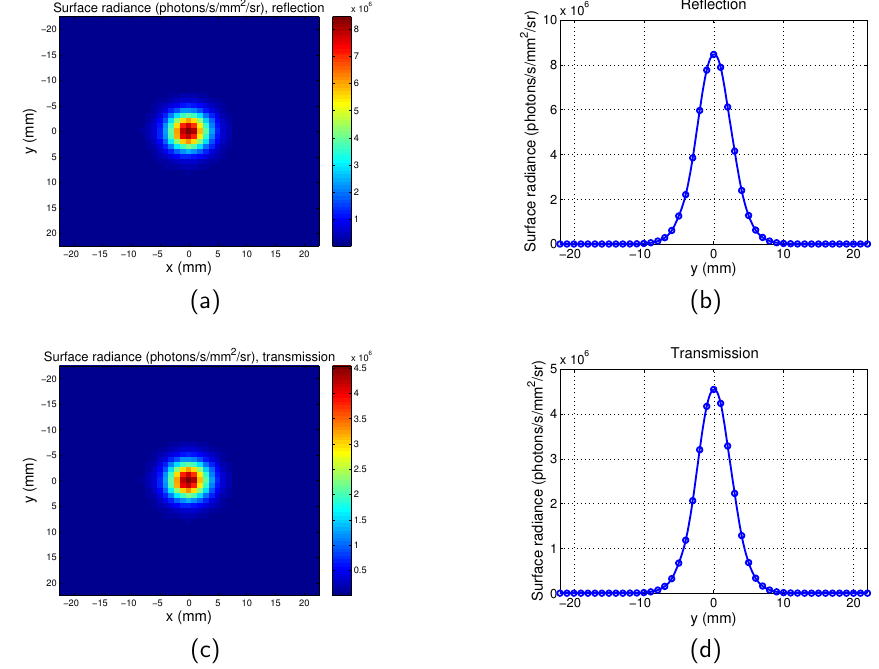
Figure A2. Point spread function for scanning imaging system. z = − 1mm, λ ex = 600nm, λ em = 700nm. ( a ) Map for reflection mode; ( b ) surface radiance along y direction for x = 0mm for reflection mode; ( c ) map for transmission mode; and ( d ) surface radiance along y direction for x = 0mm for transmission